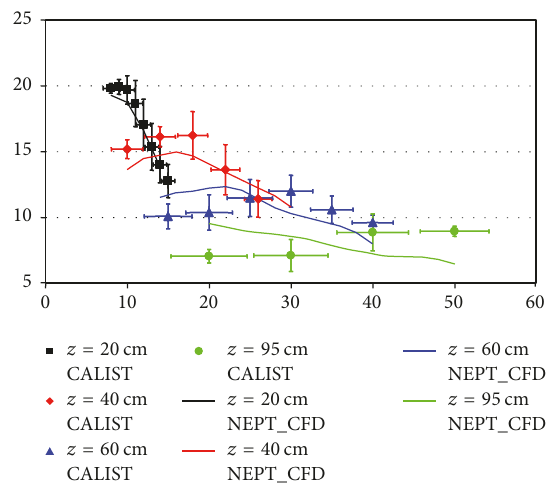
Figure 36: Axial velocity (m/s) of droplets versus radial distance (cm), monodispersed approach.